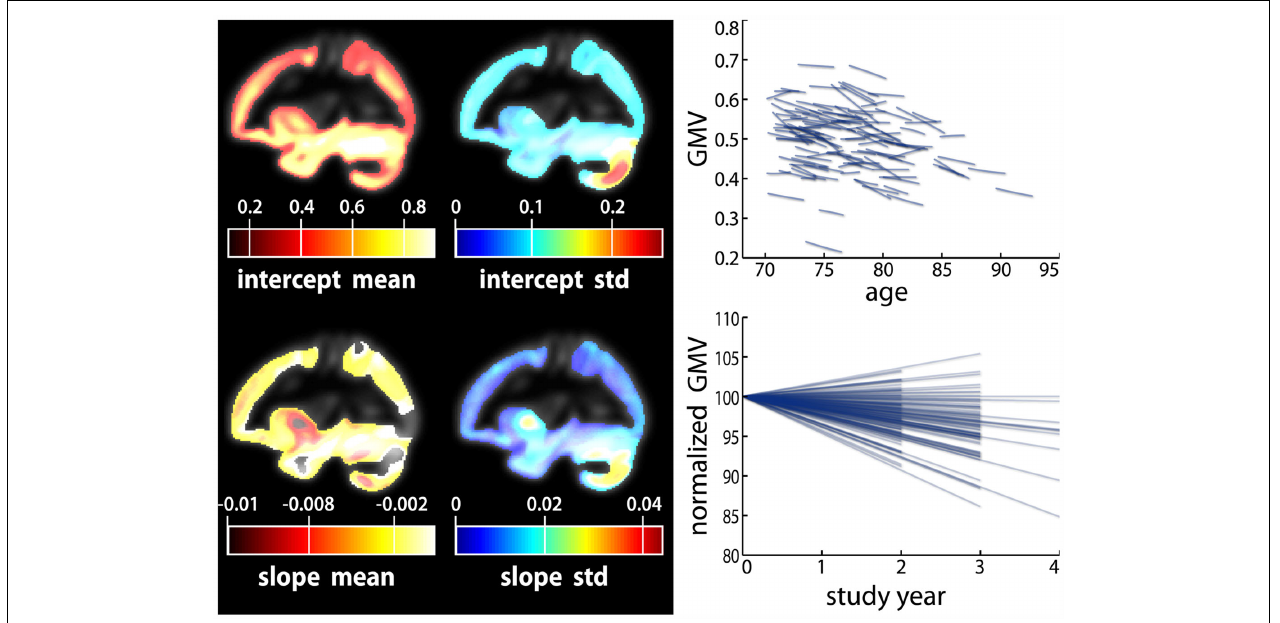
to four. Local mean and SD of intercept and slope parameters (left). Longitudinal individual linear decline models of a right hemisphere